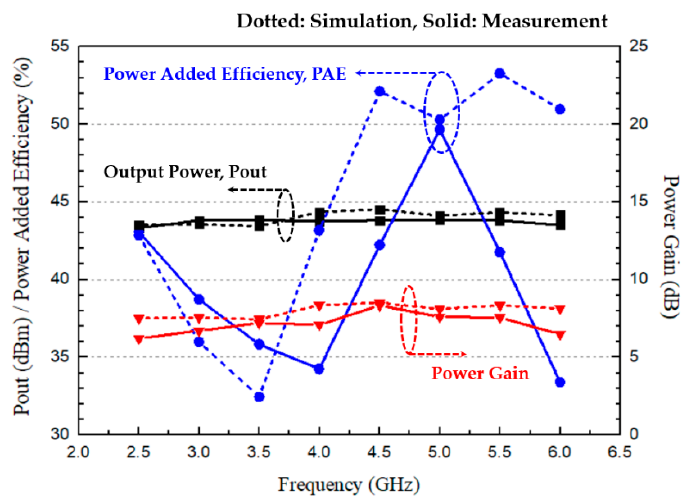
Figure 12. Measured continuous-wave output power performance of the fabricated power amplifier at V DS = 28 V and I DS = 250 mA in the frequency range of 2.5–6 GHz under the power saturation condition.